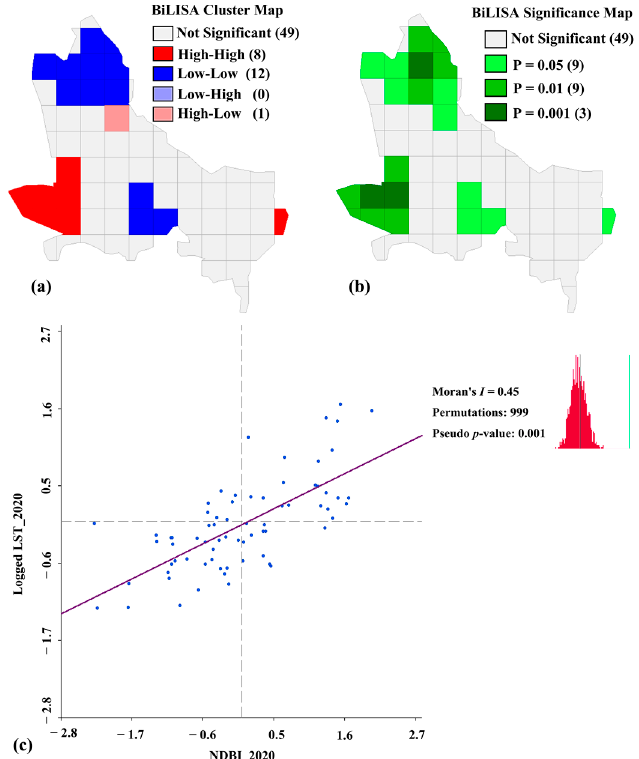
Figure 9. The resultant spatial autocorrelation between LST and NDBI, in which ( a ) represents Bi-LISA cluster, ( b ) significance maps, and ( c ) Moran’s I , for the year 2020.